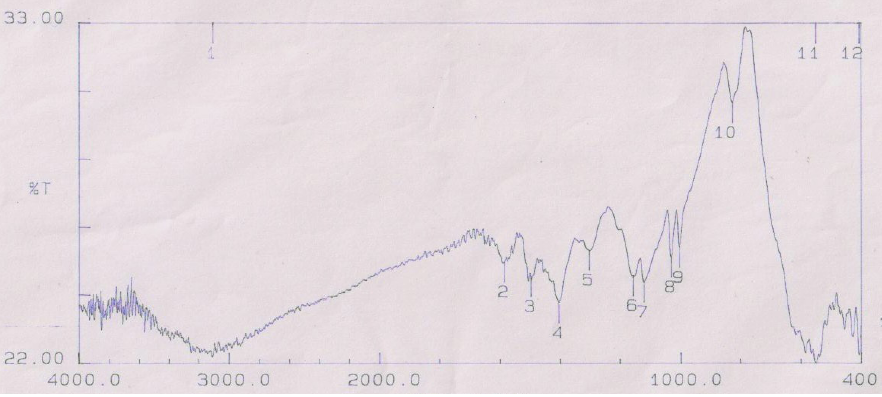
Figure 1. FTIR spectra of PTSA doped tetraaniline prepared at 1:5 molar ratio of N-phenyl- 1, 4-phenylenediamine to